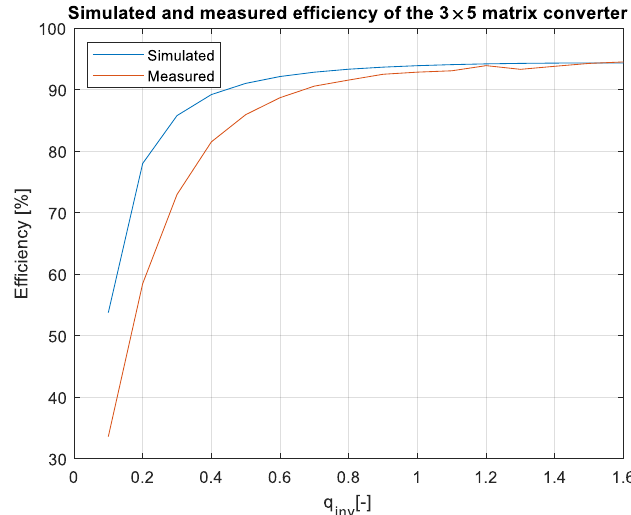
Figure 19. Comparison of simulated and measured data.